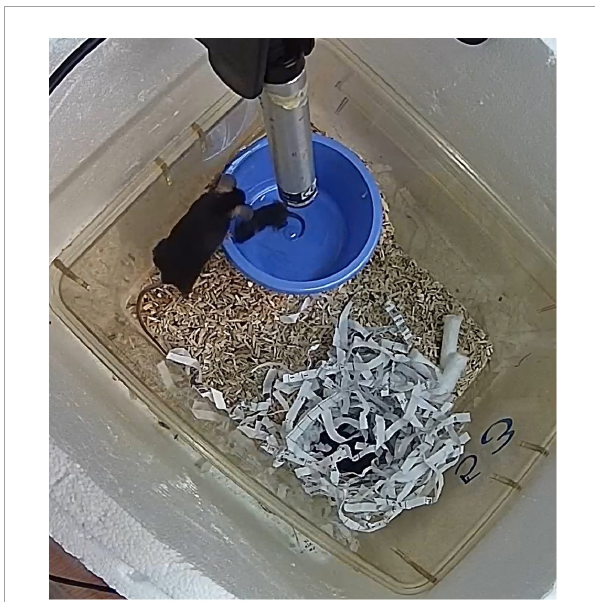
FIGURE1 Image of the BAMBI testing setup. BAMBI test was performed in the home-cage and included a cup on PND7-13 to prevent the pups from crawling back into the nest. An ultrasound microphone was placed approximately 5 cm above the test pup’s corner in order to minimize interference from USVs emitted by the pups in the nest (in the opposite corner). A video camera was mounted above the